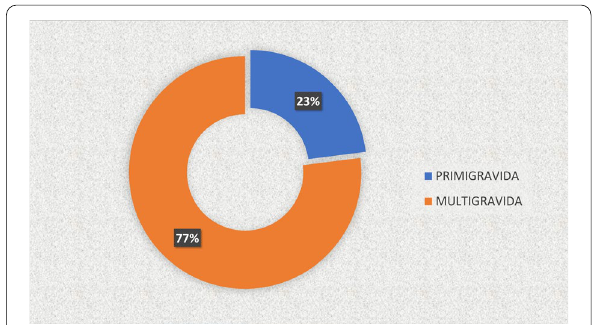
Fig. 1 Pie chart showing distribution of women according to gravidity